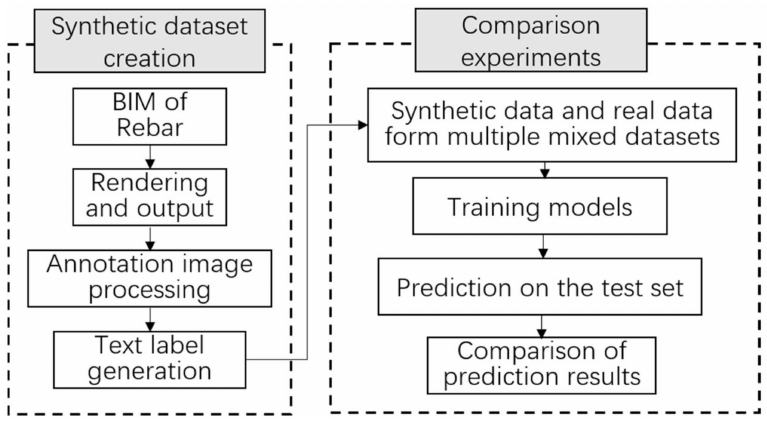
Figure 1. Synthetic dataset production and experimental